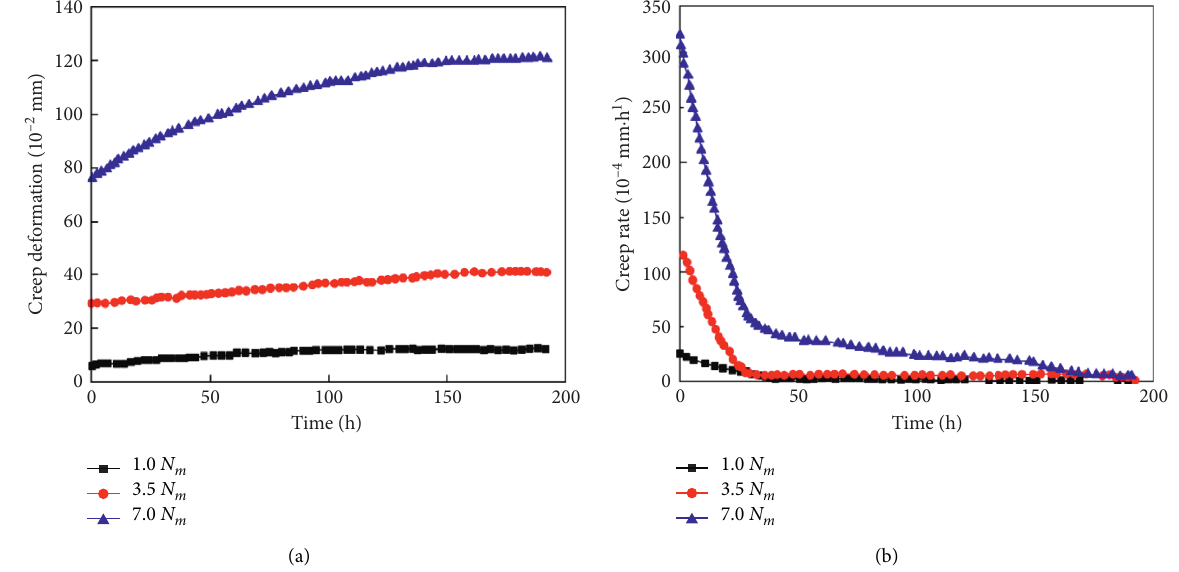
Figure 12: (a) Deformation and (b) rate of points D1-3 measured during creep testing.